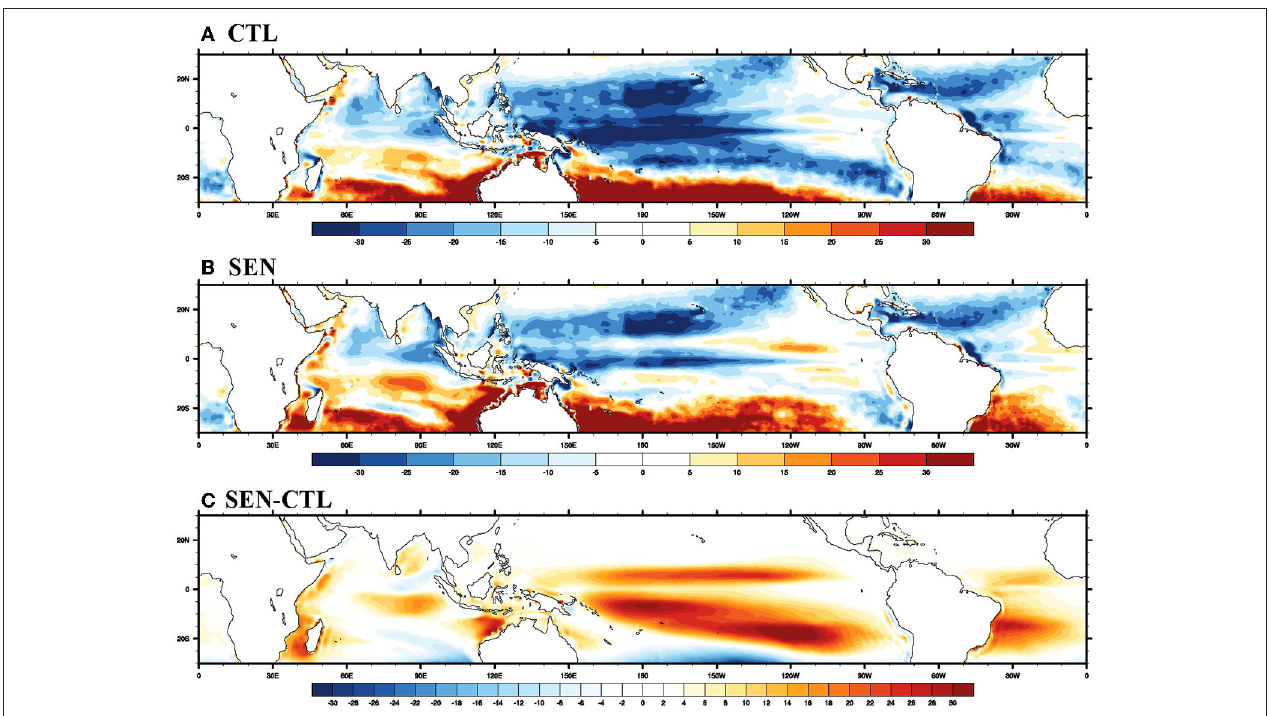
FIGURE 7 | Seasonal (JJAS) mean bias in mixed layer depth (MLD in m) of the ocean in (A) CTL run, (B) SEN run, and (C) SEN-CTL for the period of